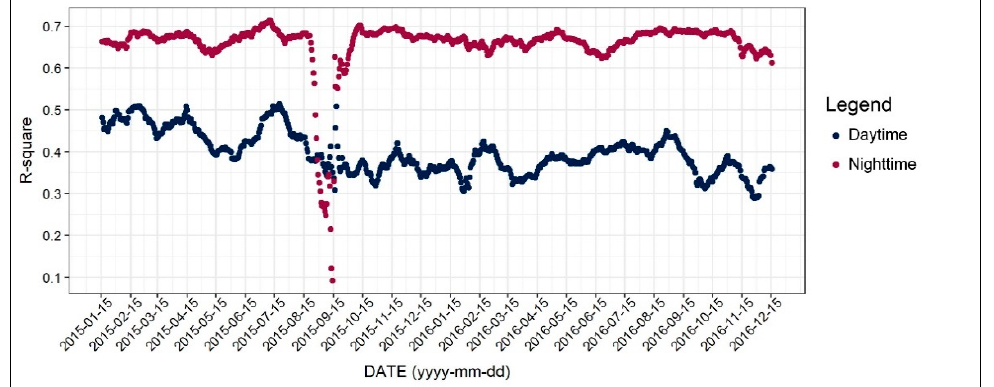
Figure 4. Changing patterns in the R-square value.